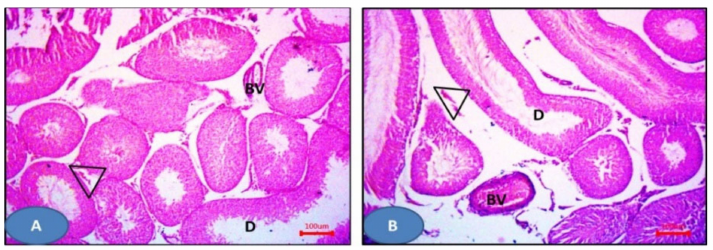
Figure 12. Photomicrographs of sections of the testis: ( A , B ) 6e and 6g respectively showing dilated seminiferous tubules (D) with distorted Leydig cells (triangles). Notice the dilated blood vessels. H&E × 100.